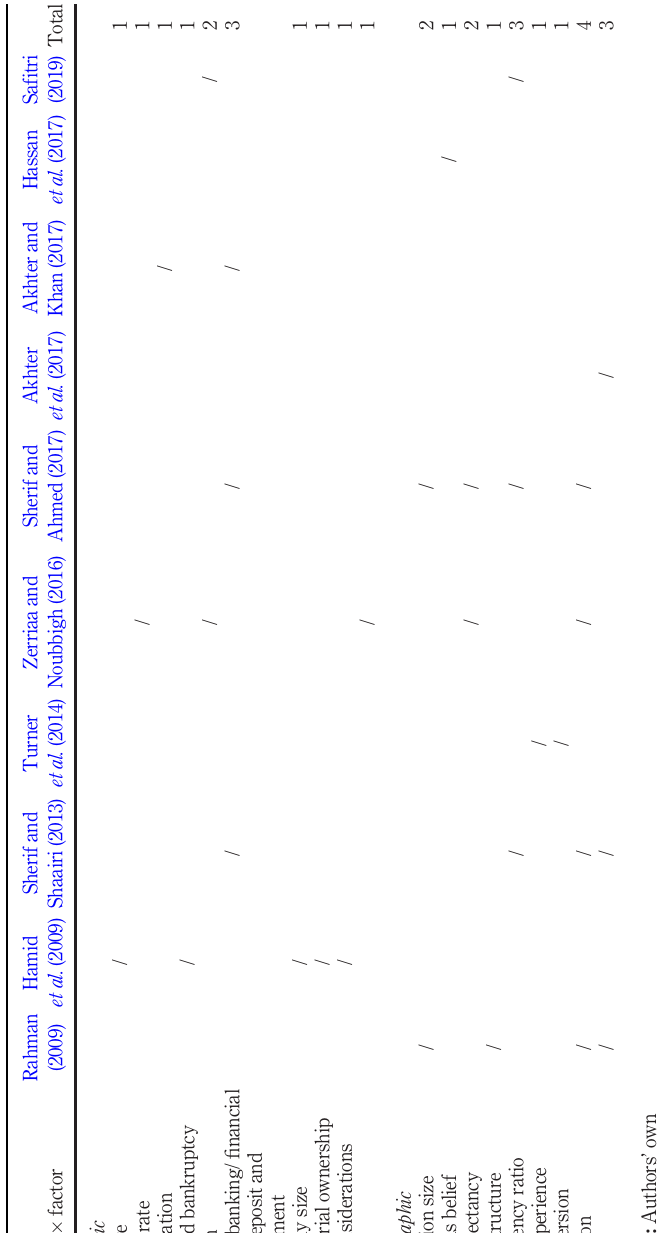
Table 4. Factors affecting